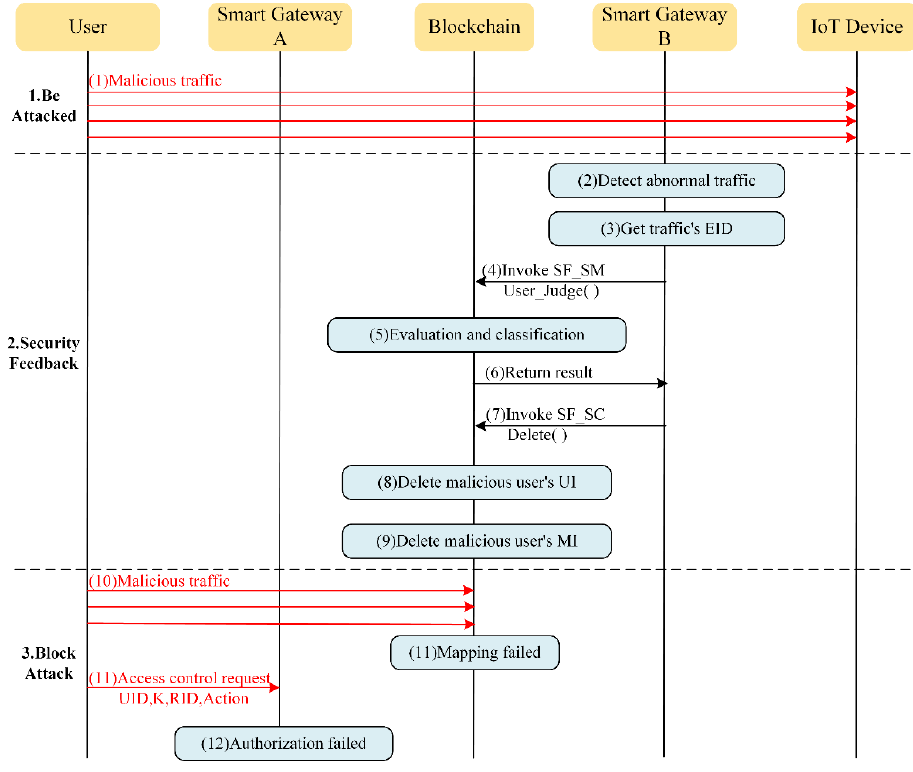
Figure 5. Workflow of system blocks malicious users from attacking resources.